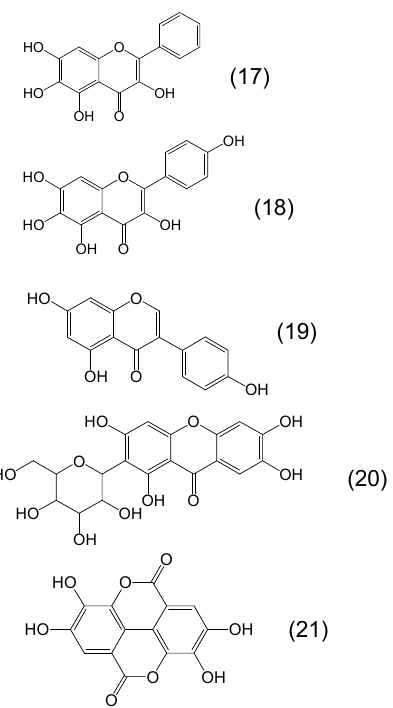
Figure 6. Examples of phytochelators with the flavonoid, isoflavonoid and xanthonoid chemical structure. Baicalein or 5,6,7-trihydroxy-2-phenyl-chromen-4-one ( 17 ), scutellarein or 5,6,7,4 ′ -tetrahydroxyflavone ( 18 ), genistein or 5,7-dihydroxy-3-(4-hydroxyphenyl)chromen-4-one ( 19 ), mangiferin or (1 S )-1,5-anhydro-1-(1,3,6,7-tetrahydroxy-9-oxo-9 H -xanthen-2-yl)- D -glucitol ( 20 ), and ellagic acid or 2,3,7,8-tetrahydroxy-chromeno[5,4,3-cde]chromene-5,10-dione ( 21 ).